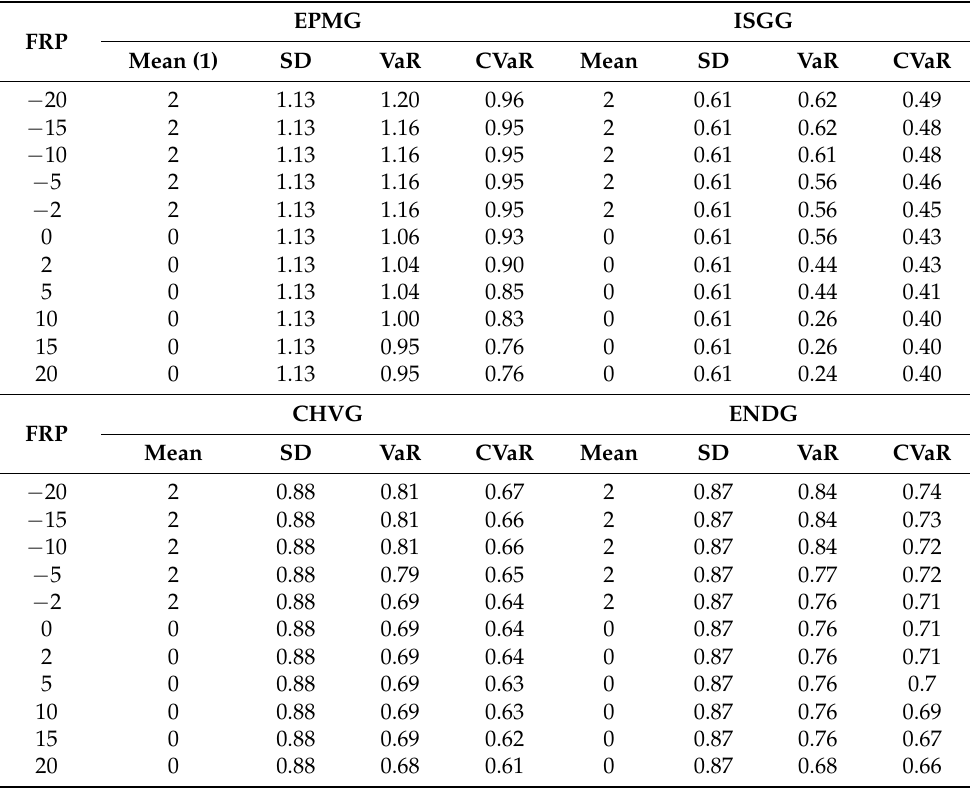
Table 5. Optimal contracting level (Eta) suggested for each